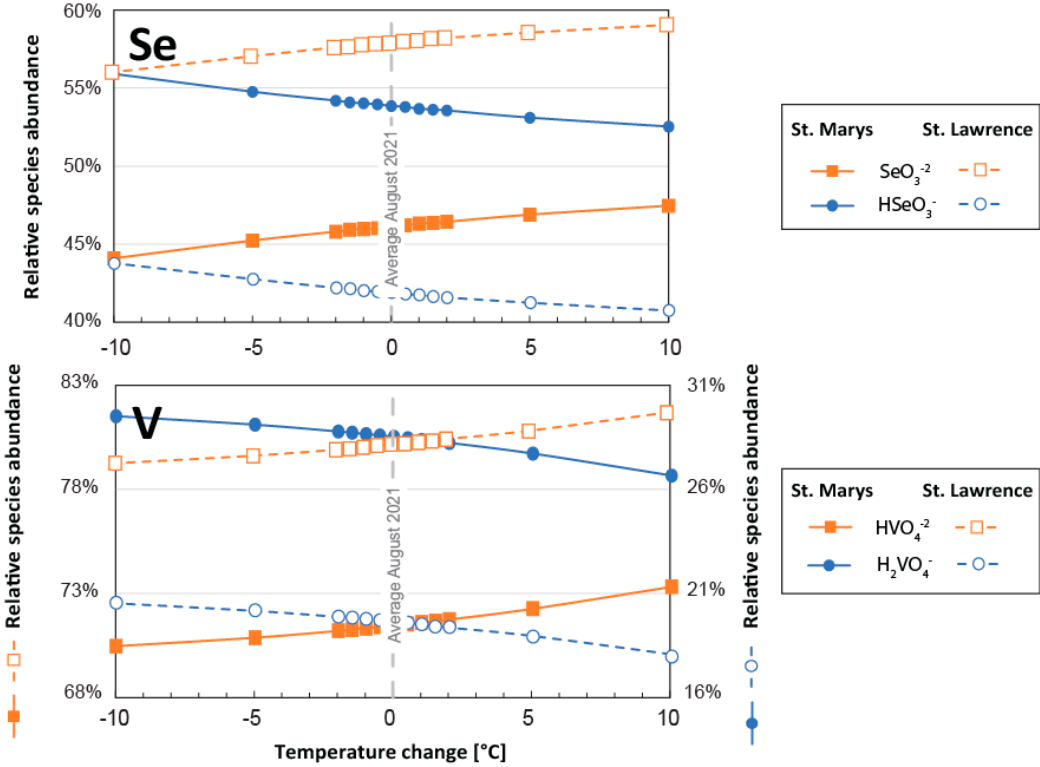
Figure 3. Geochemical equilibrium modelling of the aqueous speciation of Se (top frame) and V (bottom frame) in the St. Marys and St. Lawrence rivers in the Great Lakes basin. Plotted is the share of select individual aqueous species per elemental-total (molality basis, note the two y-axes for bottom frame) as a function of temperature.